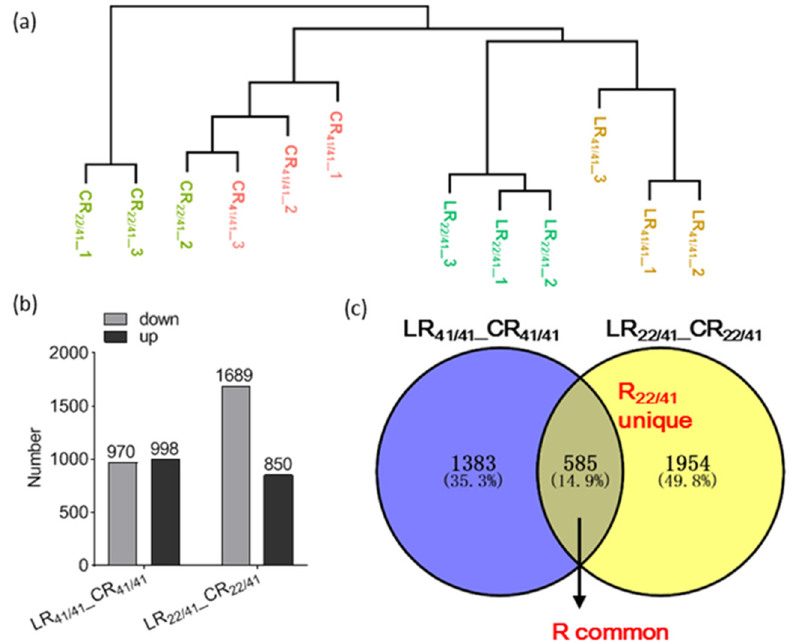
Figure 2. Transcriptome relationships among the roots of CCRI41 self-grafts (CCRI41/CCRI41, scion/rootstock) and recip- scion/rootstock) and reciprocal grafts (SCRC22/CCRI41) under potassium (K + ) deficiency. ( a ) rocal grafts (SCRC22/CCRI41) under potassium (K + ) deficiency. ( a ) Cluster dendrogram of the root transcriptomes. ( b ) Number of differentially expressed genes (DEGs) in the roots of CCRI41/CCRI41 and SCRC22/CCRI41. ( c ) Venn diagram showing shared and unique DEGs in both grafts. CR and LR: Roots from CK and LK-treated plants; 41/41: CCRI41/CCRI41; 22/41: SCRC22/CCRI41; 1, 2, and 3: Number of replicates. R common: Common DEGs in the roots of both grafts. R22/41 unique: The DEGs specifically identified in the roots of SCRC22/CCRI41.